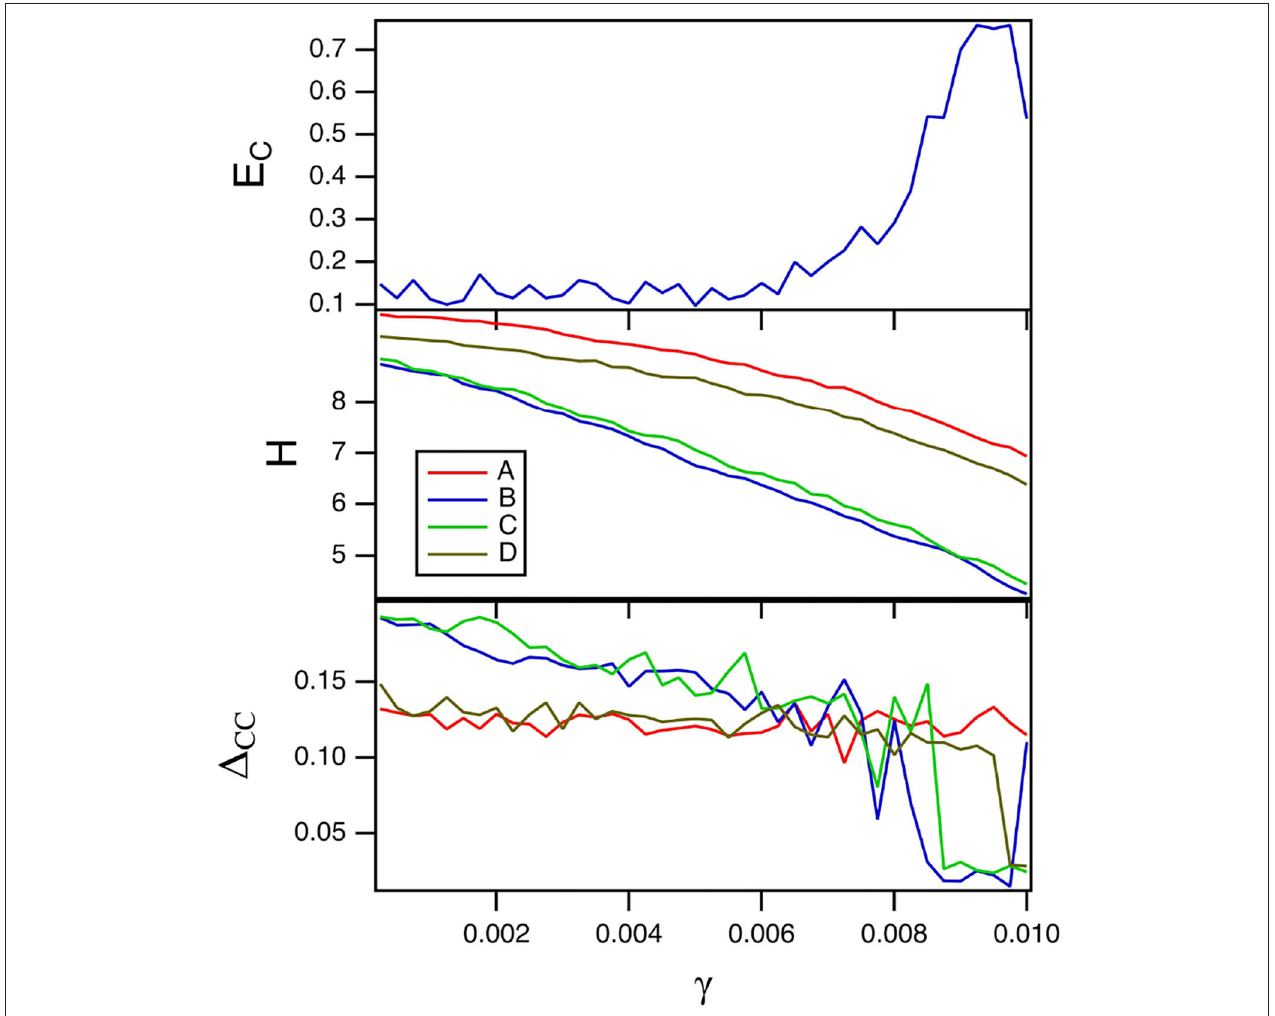
FIGURE 2 | The top plot shows the fraction of errors E C in identifying which of the four Sprott systems was present, as a function of the damping constant γ for the spiking reservoir computer. The middle plot shows the entropies for the four Sprott systems over the same parameter range. The bottom plot shows the training error 1 CC . For this plot, T C = 15 and R τ =